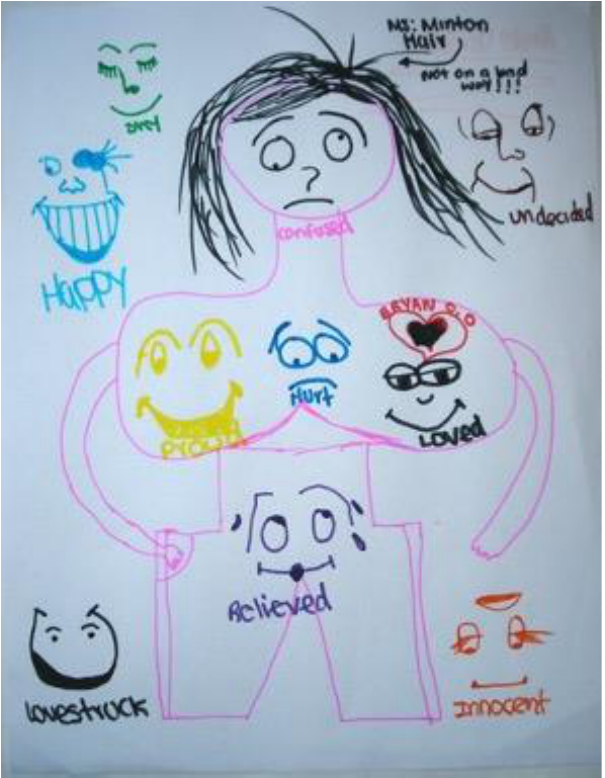
Figure 6. Normalizing and validating with peers: pregnant and parenting teens’ groups.